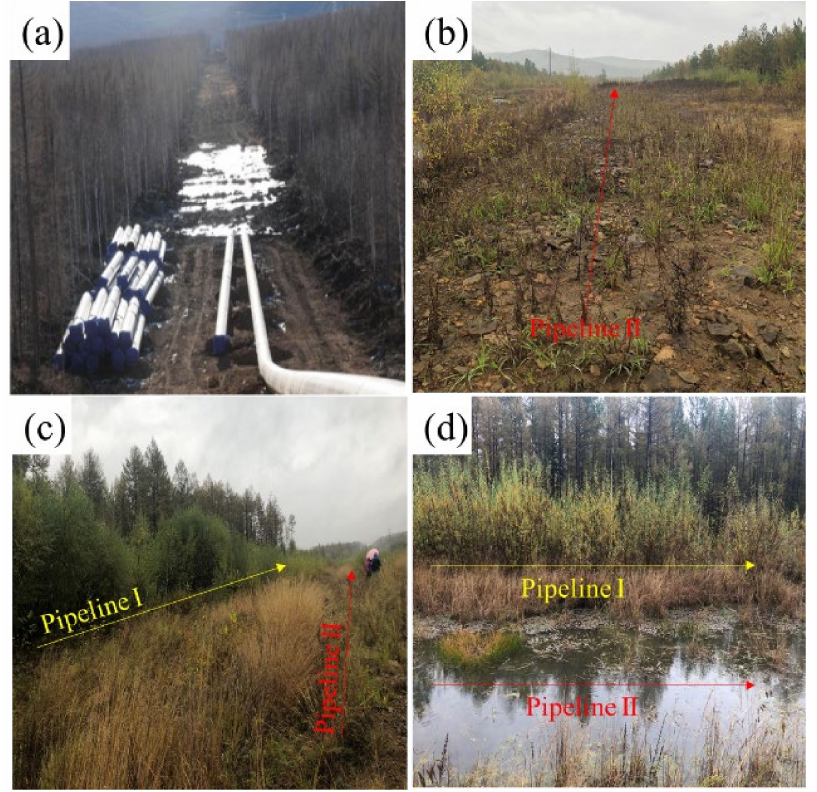
Figure 1. Construction and shrubification of the China-Russia Crude Oil Pipelines (CRCOP) I and II at the eastern flank of the northern Da Xing’anling Mountains in the northern part of northeast China. ( a ) Removal of surface vegetation in winter 2009 prior to the ditching for pipeline laying; ( b ) soil disturbances increased the presence of gravels on the ground surface immediately above the CRCOP II (photo taken in September 2020); ( c ) shrubification in the pipe ROW (photo taken in September 2020), and ( d ) thermokarst ponds in construction-disturbed area alongside the access road to the pipelines (photo taken in September 2020). Notes: The CRCOP I was built in the period from May 2009 to October 2010, and it was put into operation in January 2011; the CRCOP II was built from August 2016 to December 2017 and it was put into operation in January